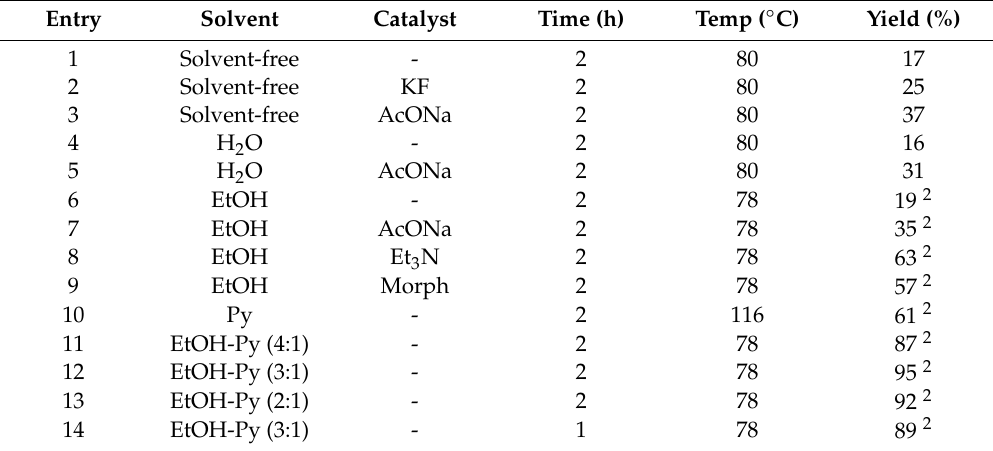
Table 1. Optimization of reaction conditions 1 .